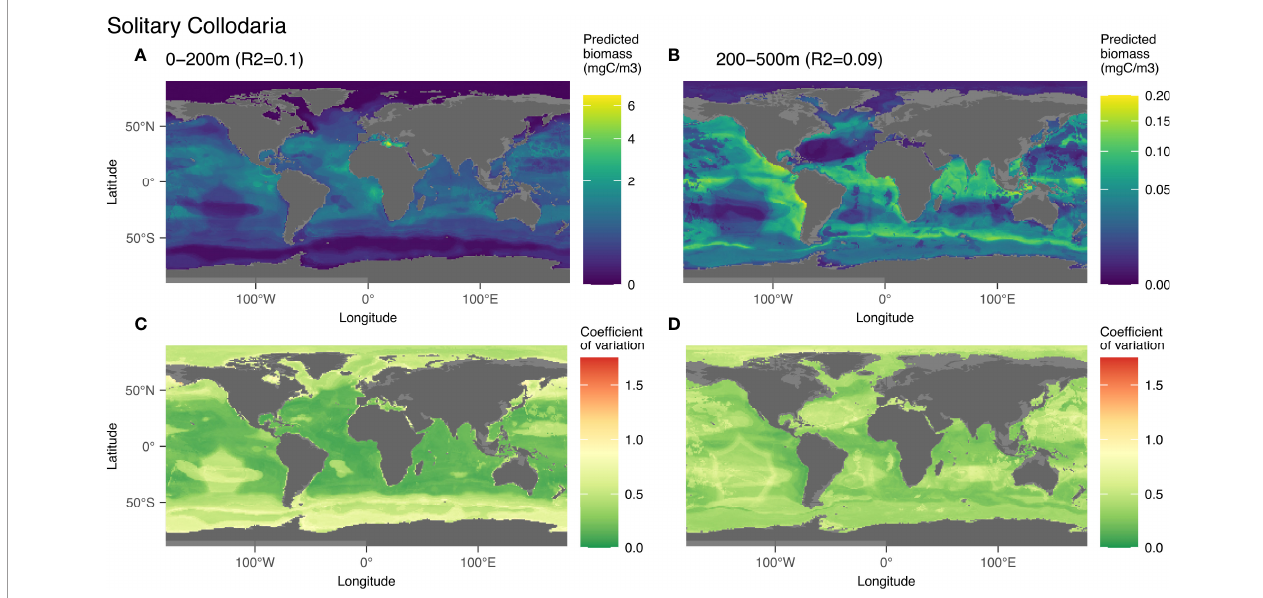
FIGURE 7 | Map of the mean biomass (color scale is log-transformed) of solitary Collodaria as predicted by themodel on 0-200 m (A) 200-500 m data (B) as well as the coef fi cient of variation for the 0-200 m model (C) and 200-500 m one (D) . The color scale for the coef fi cient of variation has the same range for Figures 5 – 9